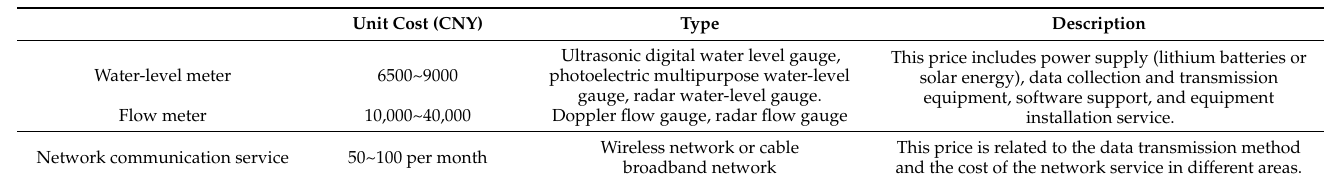
Table 4. The unit cost of data monitoring and network communication